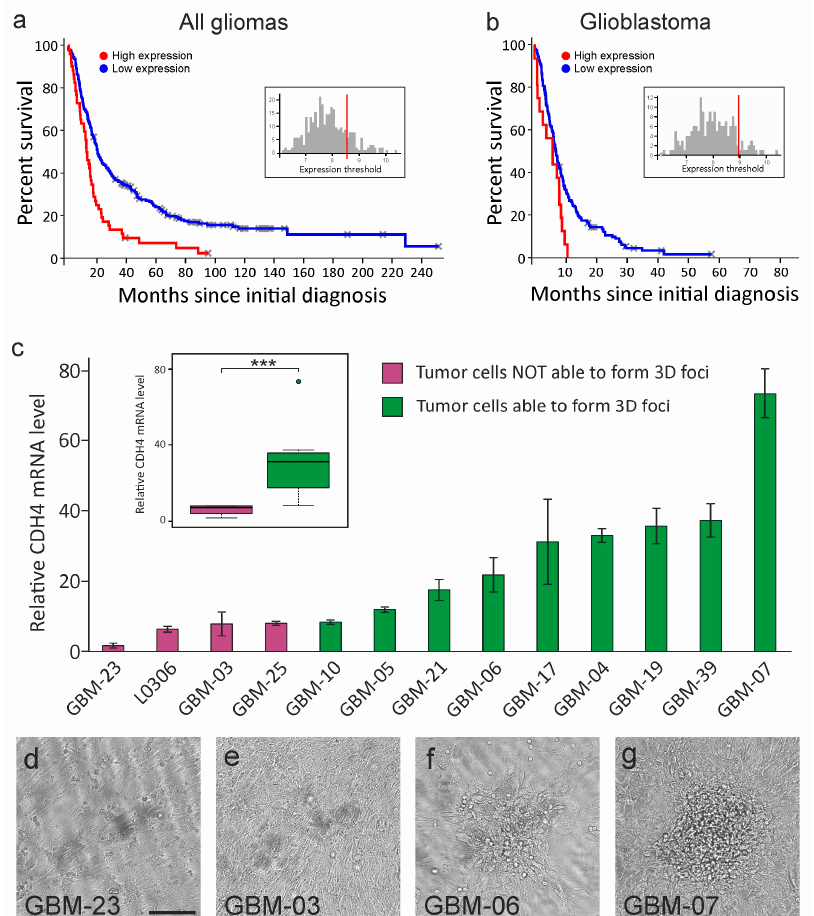
Figure 1. Cdh4 expression in human gliomas. ( a , b ) Kaplan–Meier curves of all glioma ( a ) or glioblastoma ( b ) patients with low or high Cdh4 expression level. The inset shows the frequency plot of Cdh4 expression level in the analyzed tumors. Threshold was chosen to group in the high expression pool tumors with a Cdh4 expression level higher respect to healthy tissue. ( c ) The histogram shows the quantification by quantitative PCR of Cdh4 mRNA level in di ff erent human glioblastoma initiating cells (GIC) cultures normalized to GBM-23, which have the lowest Cdh4 expression level. Purple bars represent GICs whose proliferation is inhibited by cell–cell contact, while green bars represent GICs able to proliferate over cell confluence. The barplot in the inset shows the di ff erential Cdh4 expression levels between these two groups of GICs. ( d – g ) Bright field micrographs representing over confluence GIC cultures. Scale bar: 500 µ m. *** p < 0.001.